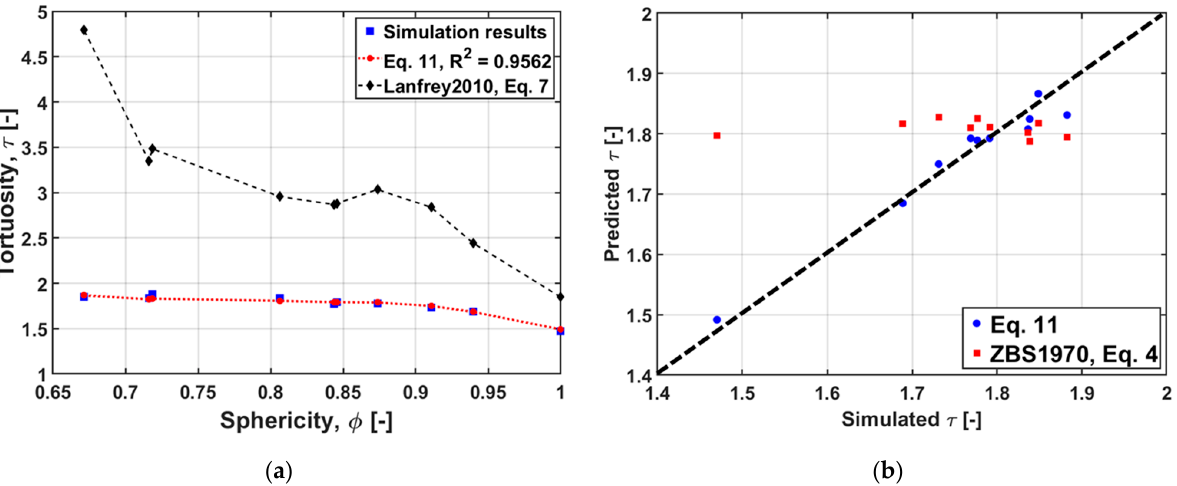
Figure 11. ( a ) Comparison of the change in tortuosity with sphericity according to the proposed model and the Lanfrey model and ( b ) comparison between simulated tortuosity values with ZBS predictions and with values predicted by the here developed model, according to Equation (11).